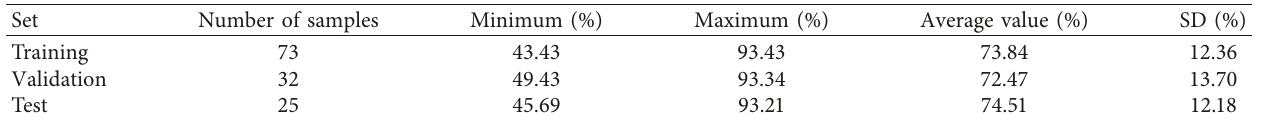
Table 2: Information of sample classification.